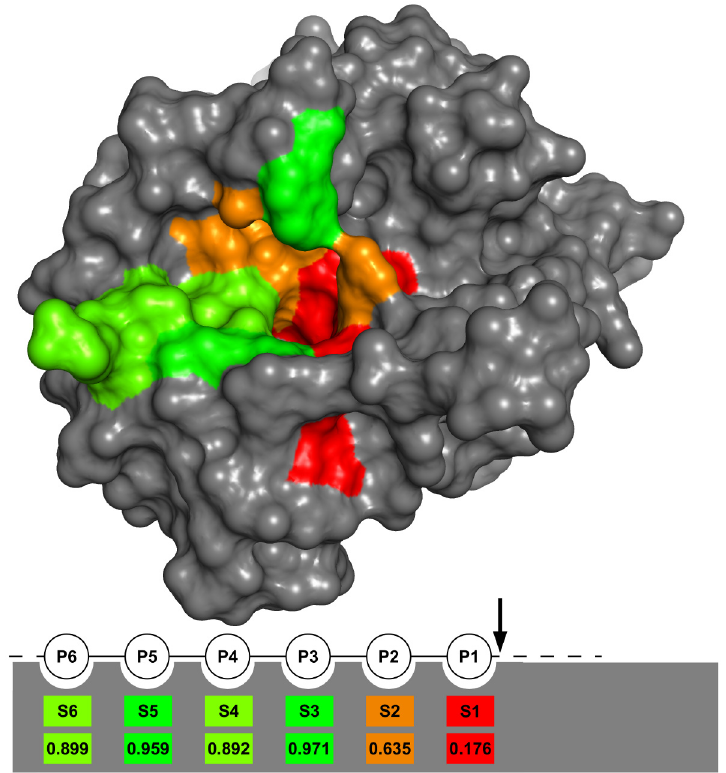
Fig 1. Cleavage entropy mapped to non-prime side thrombin sub-pockets. Mapping of cleavage entropy to thrombin sub-pockets shows S1 sub-pocket as most specific sub-pocket with a cleavage entropy < 0.2, followed by the S2 sub-pocket with a cleavage entropy < 0.7. Sub-pockets S3-S6 show little to almost no specificity with values for the cleavage entropy between 0.89 and 0.97.